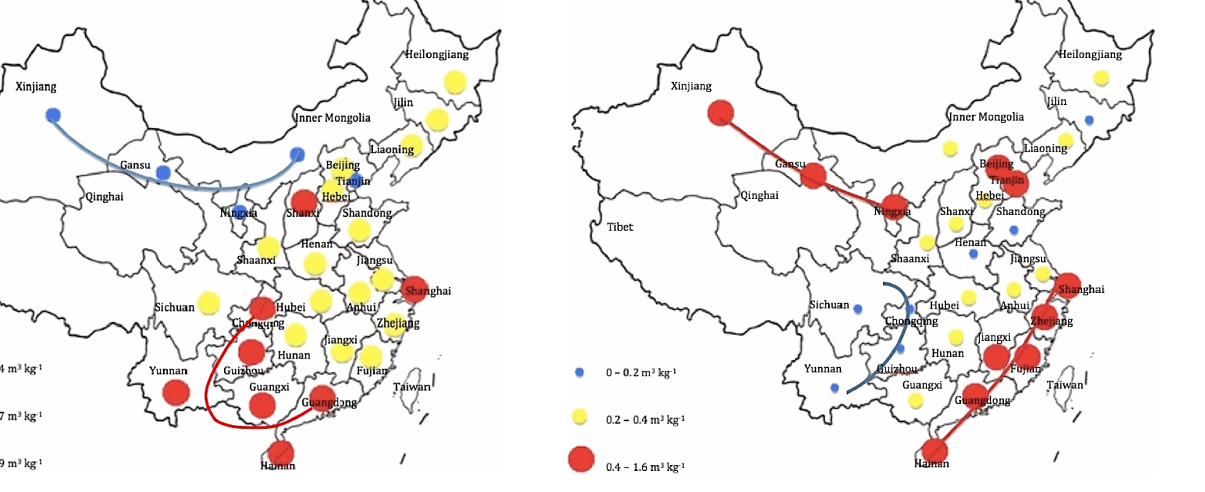
Figure 2. Direct green water of rice (m 3 kg − 1 ) . Figure 3. Direct blue water of rice (m 3 kg − 1 )